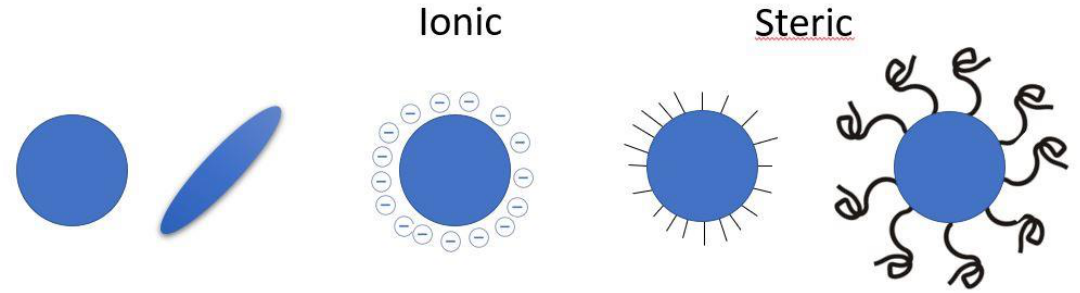
Figure 1. Schematic drawing of spherical and shape-anisotropic nanoparticles (left) and ways of stabilization by ionic and steric stabilization [8,10,20,21].